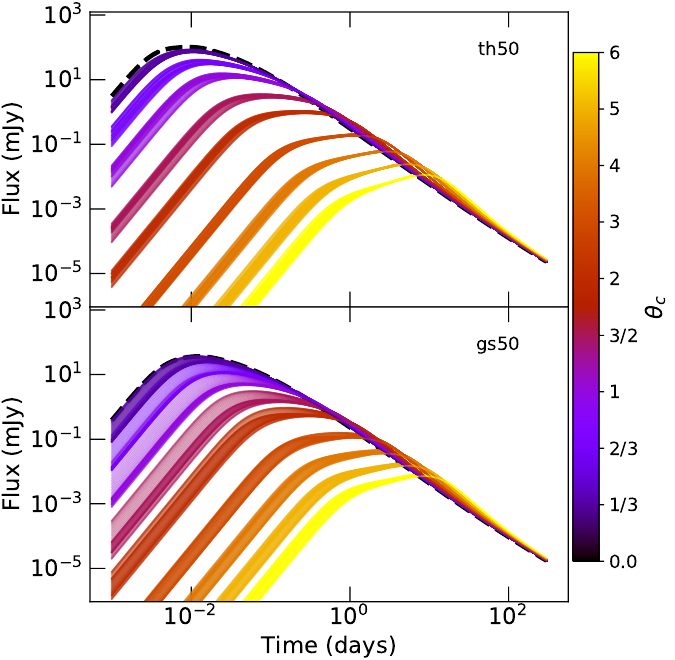
Figure 2. Lightcurves in i -band at various polar angles, θ , from the jet central axis. Here the polar angle is equivalent to the system inclination, θ ≡ ι , and shown in the colour bar as a fraction of the effective core angle for each profile, where the line colour indicates the relative angle in terms of core size—the discrete angles shown correspond to the colour bar labels. The effective core angles for each model, θ c , are given in Table 1. At each θ ≡ ι , lightcurves at all available rotational orientations, 0 ≤ φ ≤ 2 π , are shown in the same colour. Here the apparent broadness of the lines is indicative of the spread in flux as a result of the rotational orientation, φ , of the jet to the line-of-sight. For a fixed inclination angle, the rotational orientation of the system has a significant effect on the flux density at ∼ peak time, or equivalently the deceleration time, for an observer ι (cid:46) θ c . Where ι (cid:38) 2 θ c , then only the early and pre-peak flux density is sensitive to the rotational orientation. The dashed line indicates the ι = 0, perfectly on-axis afterglow